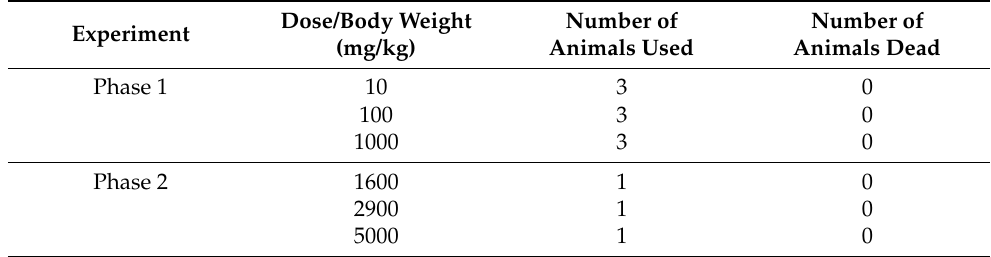
Table 2. Acute toxicity after orally administering the crude methanolic extract (CME) of G. kola to the experimental